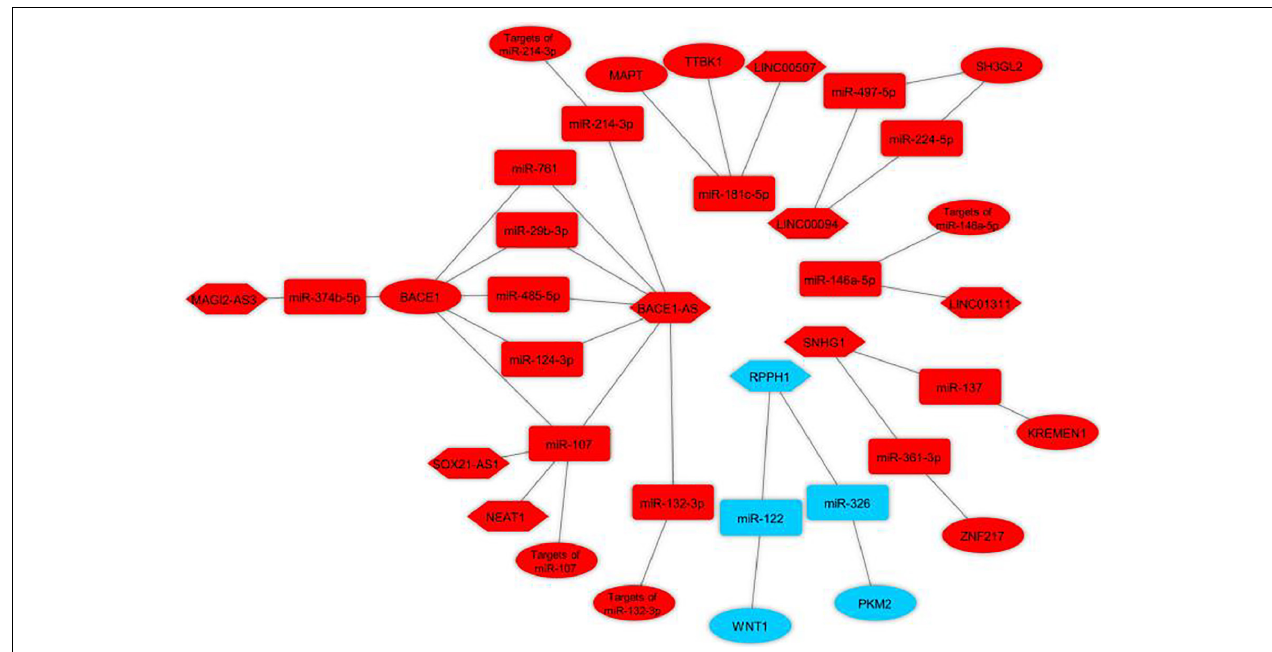
FIGURE 3 | Validated lncRNA-associated ceRNA axes in Alzheimer’s disease. The loops were visualized using Cytoscape v3.8.0 software (Shannon et al., 2003) based on lncRNA-miRNA-mRNA interactions. Red represents the damaging role, and blue represents the protective role of competing endogenous RNA axes. LncRNAs, miRNAs, and mRNAs are represented by hexagon, round rectangle, and ellipse, respectively. LncRNA, long non-coding RNA; miRNA,